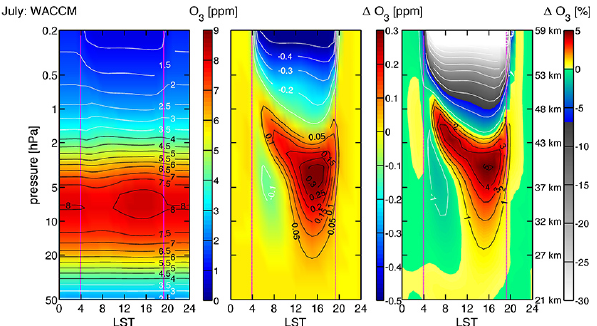
Figure 5a. Mean diurnal ozone variation of WACCM between 50 and 0.2hPa for July. The left, middle and right panel are described in Fig. 4a.